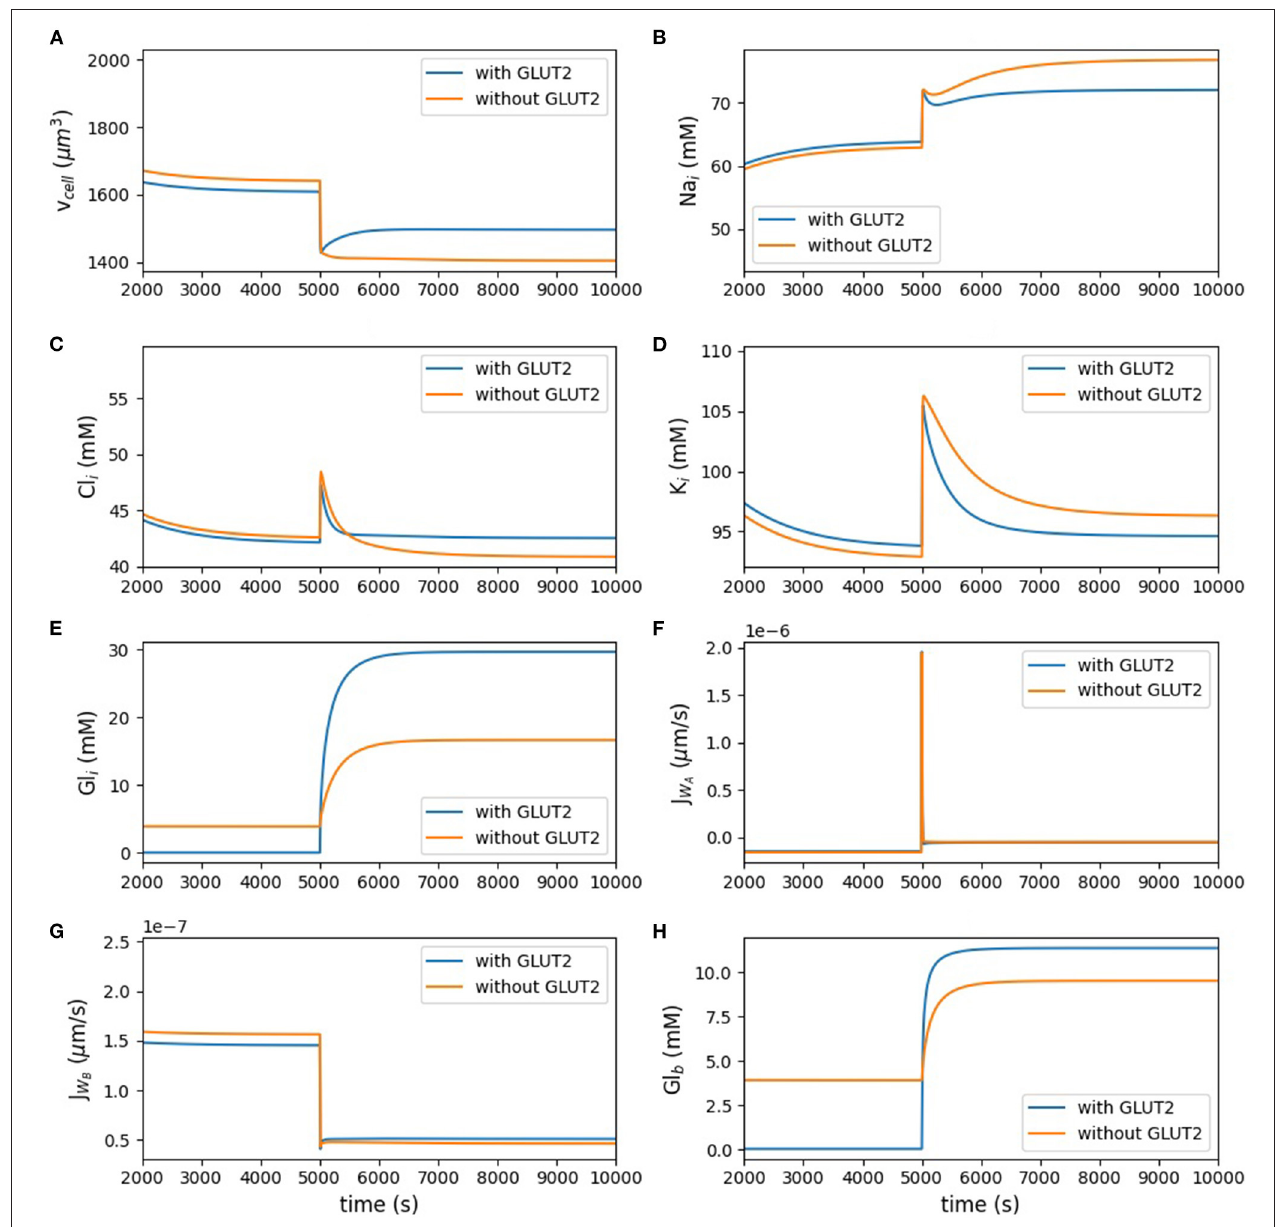
FIGURE 3 | Model behaviour in the absence of luminal glucose ( t < 5,000 s) and following a step change to 50 mM luminal glucose (5,000 ≤ t < 10,000 s) of the simulation. (A) cell volume; (B) intracellular concentrations of sodium; (C) chloride; (D) potassium; (E) glucose; (F,G) apical and basolateral water flux; (H) blood